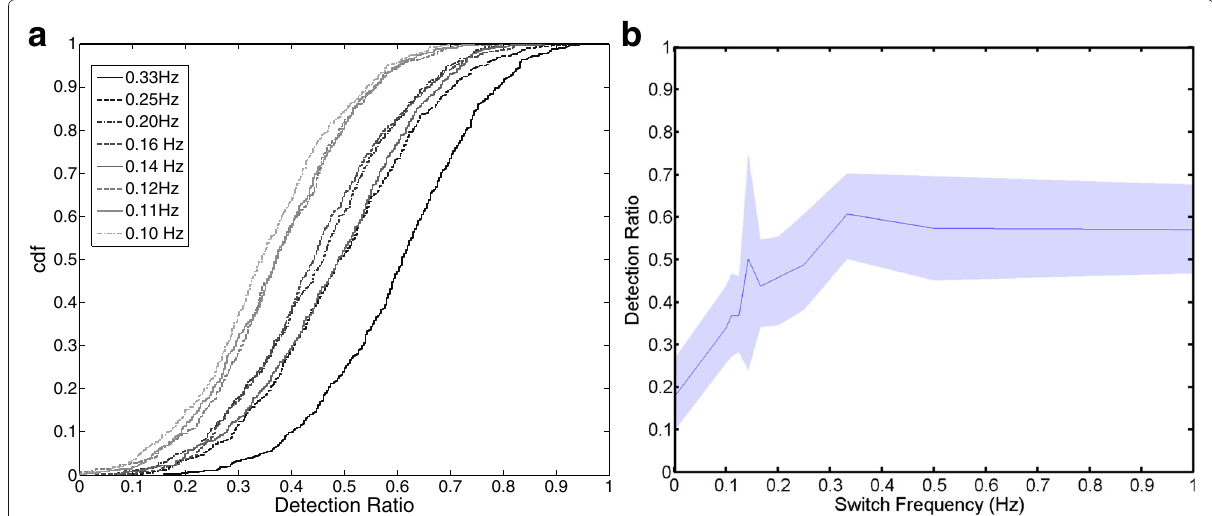
Fig. 7 Numeric simulation results using the multi-watermark detection scheme. a Cumulative distribution function (CDF) of the detector under different switching frequencies. b Median detection ratio function per switching frequency, in which the shadedarea corresponds to the 25 and the 75% (i.e., confidence intervals). a CDF and detection ratio per switching frequency. b Detection ratio function with respect to the switching